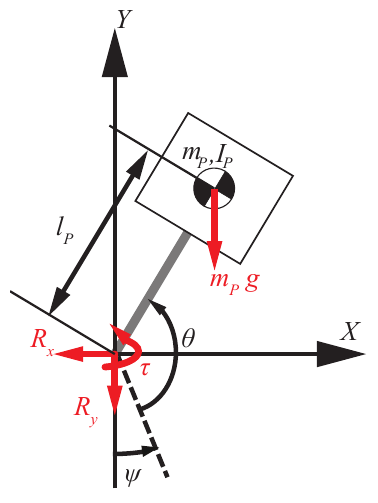
Figure 1. Robot’s spinner free body